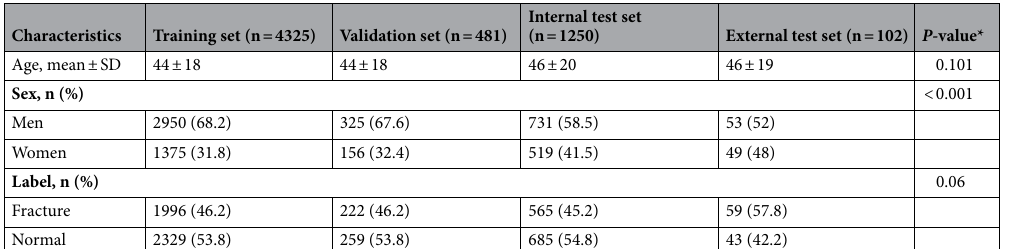
Table 1. Baseline characteristics of patients. SD standard deviation. * P -values were calculated using one-way ANOVA or Pearson’s Chi-squared test, where